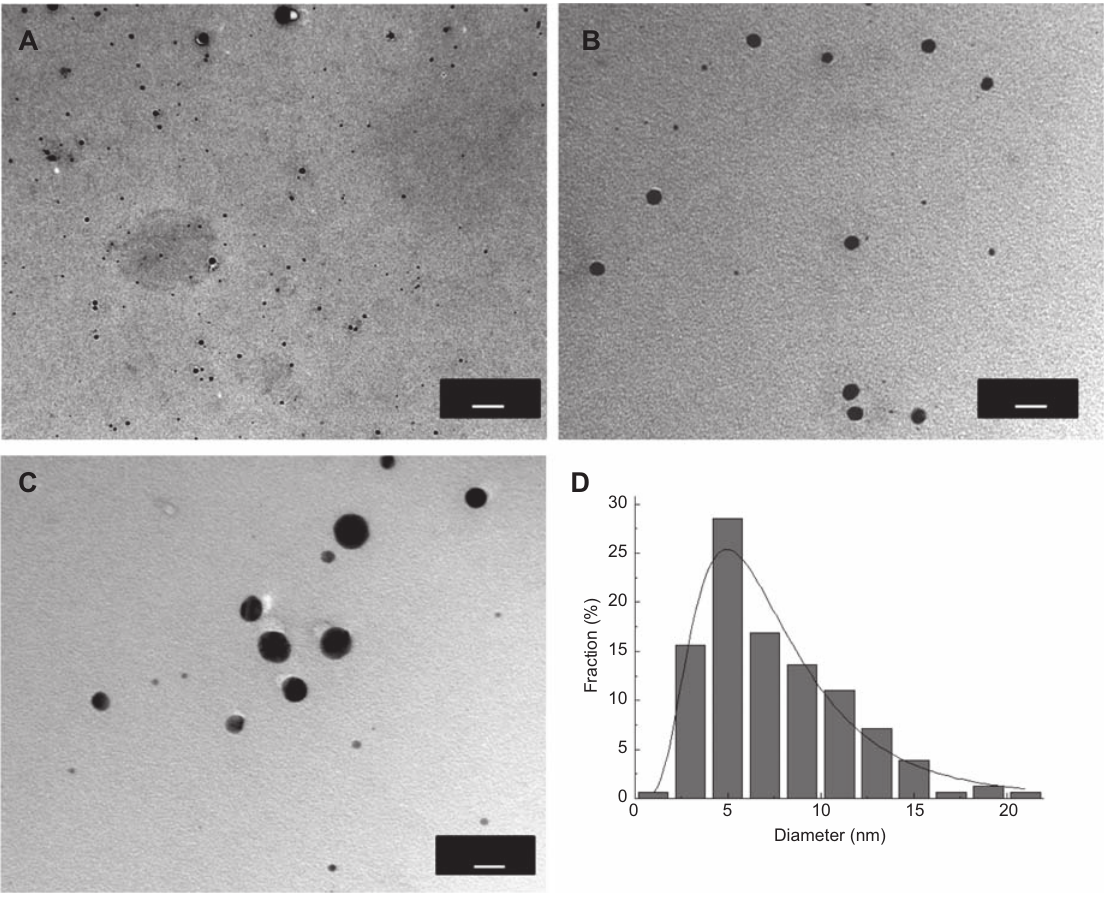
Figure 3 TEM-micrographs of a nanocomposite sample at different magnifi cations (A, B, and C) and related size distribution histogram of Ag nanoparticles (the solid curve is a lognormal distribution centered at 6.6 ± 0.5 nm) (D).